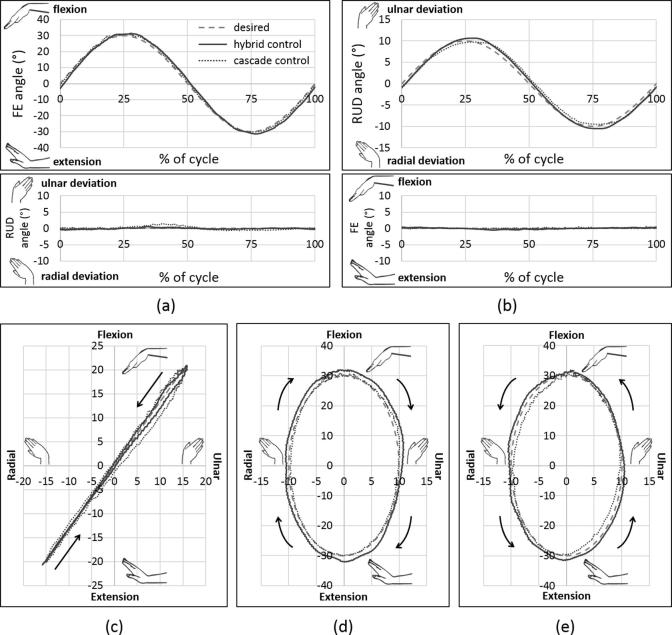
In-plane and out-of-plane kinematics for planar motions – (a) flexion-extension and (b) radioulnar deviation – and trajectories of complex motions – (c) dart thrower’s motion (d) clockwise circumduction and (e) anticlockwise circumduction – in hybrid control (solid lines) and cascade control (dotted lines), as compared to the desired kinematics and trajectories (dashed lines), with the hand in the vertically upward orientation, for a representative cycle of one of the specimens (X-axis represents radioulnar deviation, Y-axis represents flexion-extension).